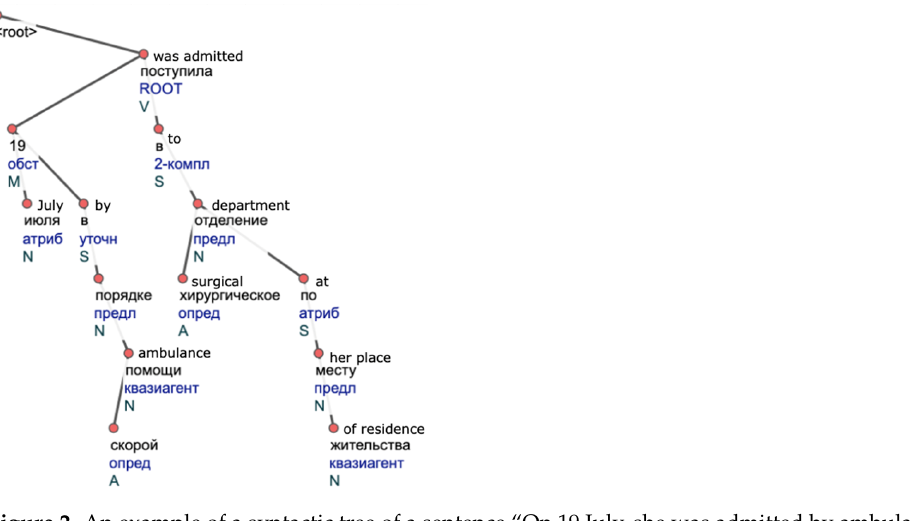
Figure 2. An example of a syntactic tree of a sentence “On 19 July, she was admitted by ambulance to the surgical department at her place of residence” in a CoNLL-U format.